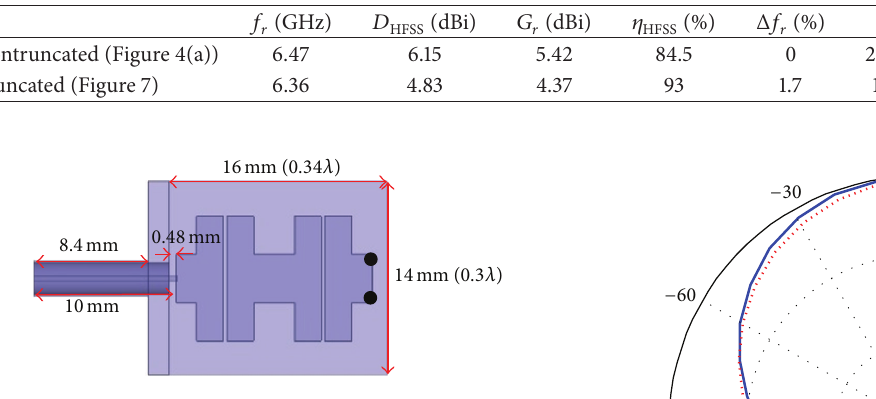
stands for the realized gain. r